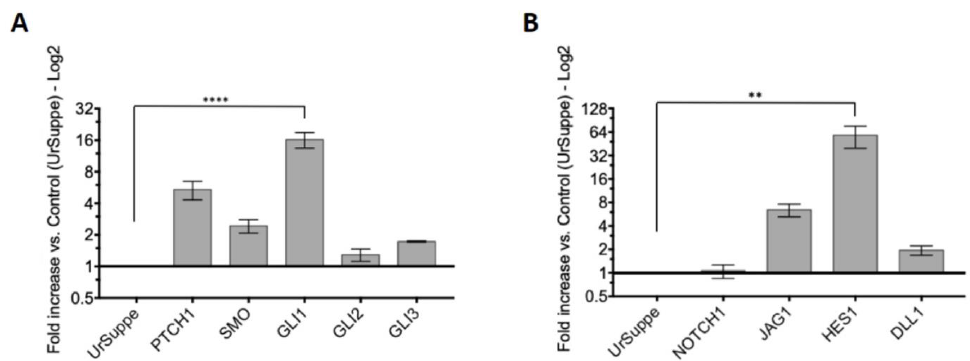
Figure 3. Detection by RT-qPCR of the Hh signaling core transducing and effector genes. Human ASCs were cultured for 5 days in the Hh signaling pathway permissive US-24 with SAG and Insulin medium. ( A ) Hh signaling core transducing genes. ( B ) Some Notch signaling core transducing genes and crosstalk between Hh and Notch. The calculated expression levels of the different markers of induced hASCs are related to the value obtained from the same cells cultured in the UrSuppe medium. We do not show the Hedgehog acyltransferase ( HHAT ) mRNA expression in the graphs because did not change between the two conditions, while the Delta-like 4 ( DLL4) gene is undetectable in both cell culture media ( n = 3, error bars represent S.E.M., p value; **: p value < 0.01; ****: p value <